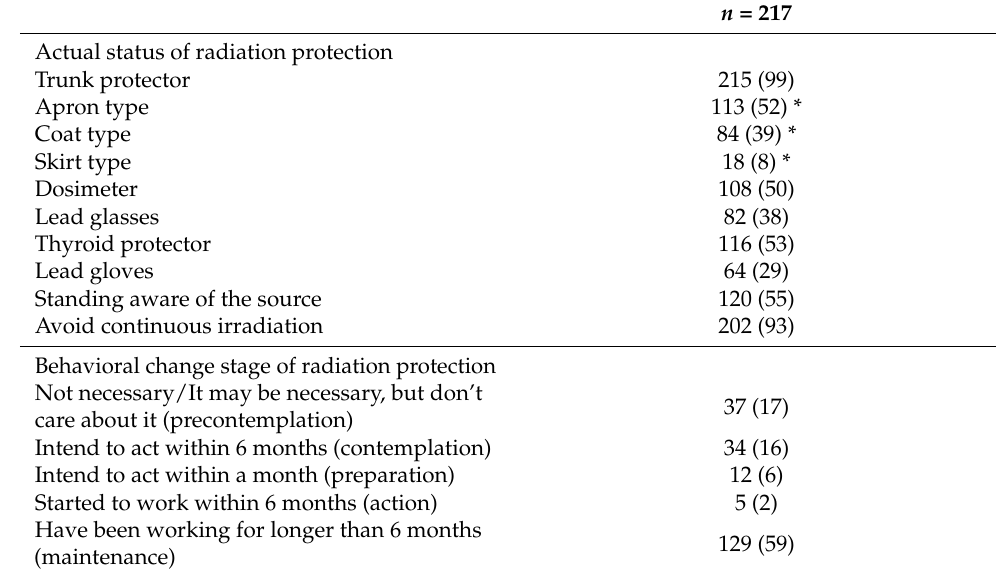
Table 2. Actual status and stage of behavioral change of radiation protection.